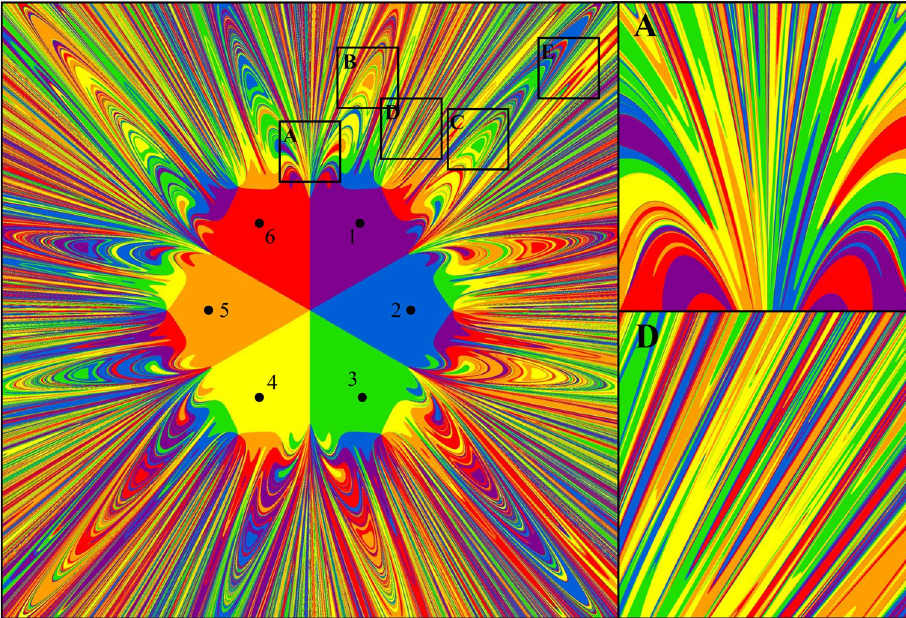
Figure 1. Gravitational fractals in a CPT system. Legend: Points 1–6 represent six distinct cities (with six different colors) in a hexagonal force field; ( A and D ) represent illustrative